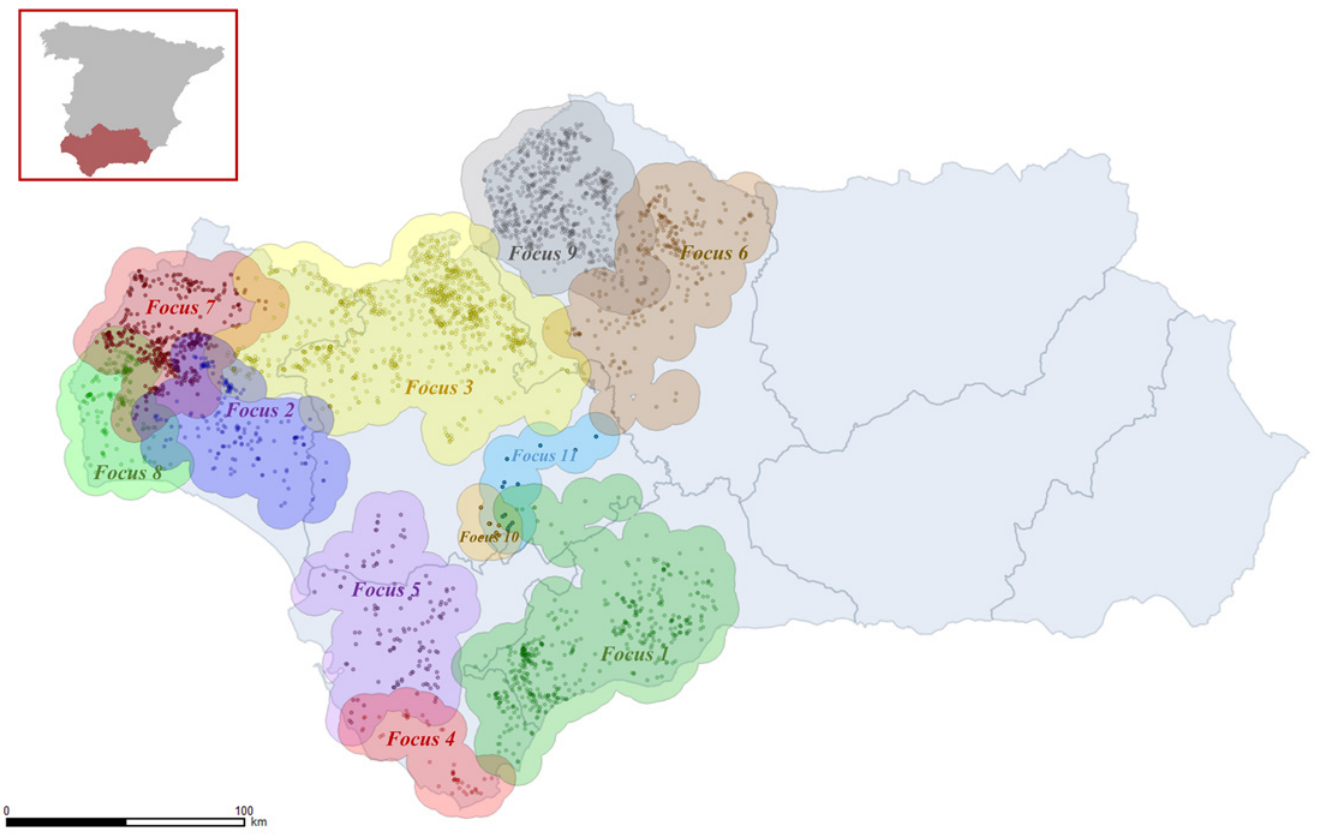
Fig 2. Spatial distribution of the farms affected plus buffer areas of the first 11 foci identified during the BTV-1 epidemic in Andalusia in 2007.